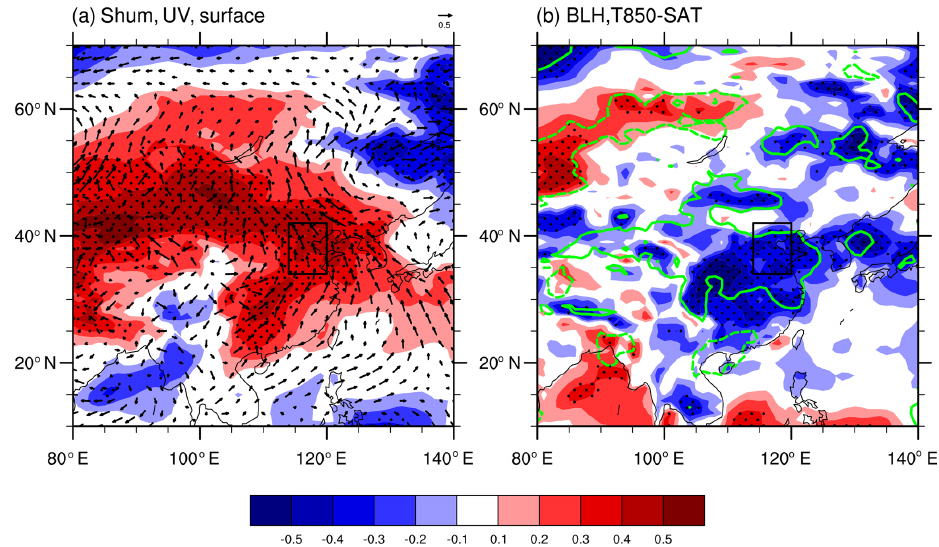
Figure 14. The CC between the November SST BA and (a) surface wind (arrow), specific humidity (Shum, shading) at 1000hPa, (b) BLH (shading) and thermal inversion potential (contour) from 1979 to 2015. The black dots indicate that the CCs exceeded the 90% confidence level, and the solid (dashed) green lines indicate that the positive (negative) correlations exceeded the 90% confidence level ( t tests). The linear trend was removed. The black boxes represent the NCP area. The thermal inversion potential was defined as the air temperature at 850hPa minus SAT.